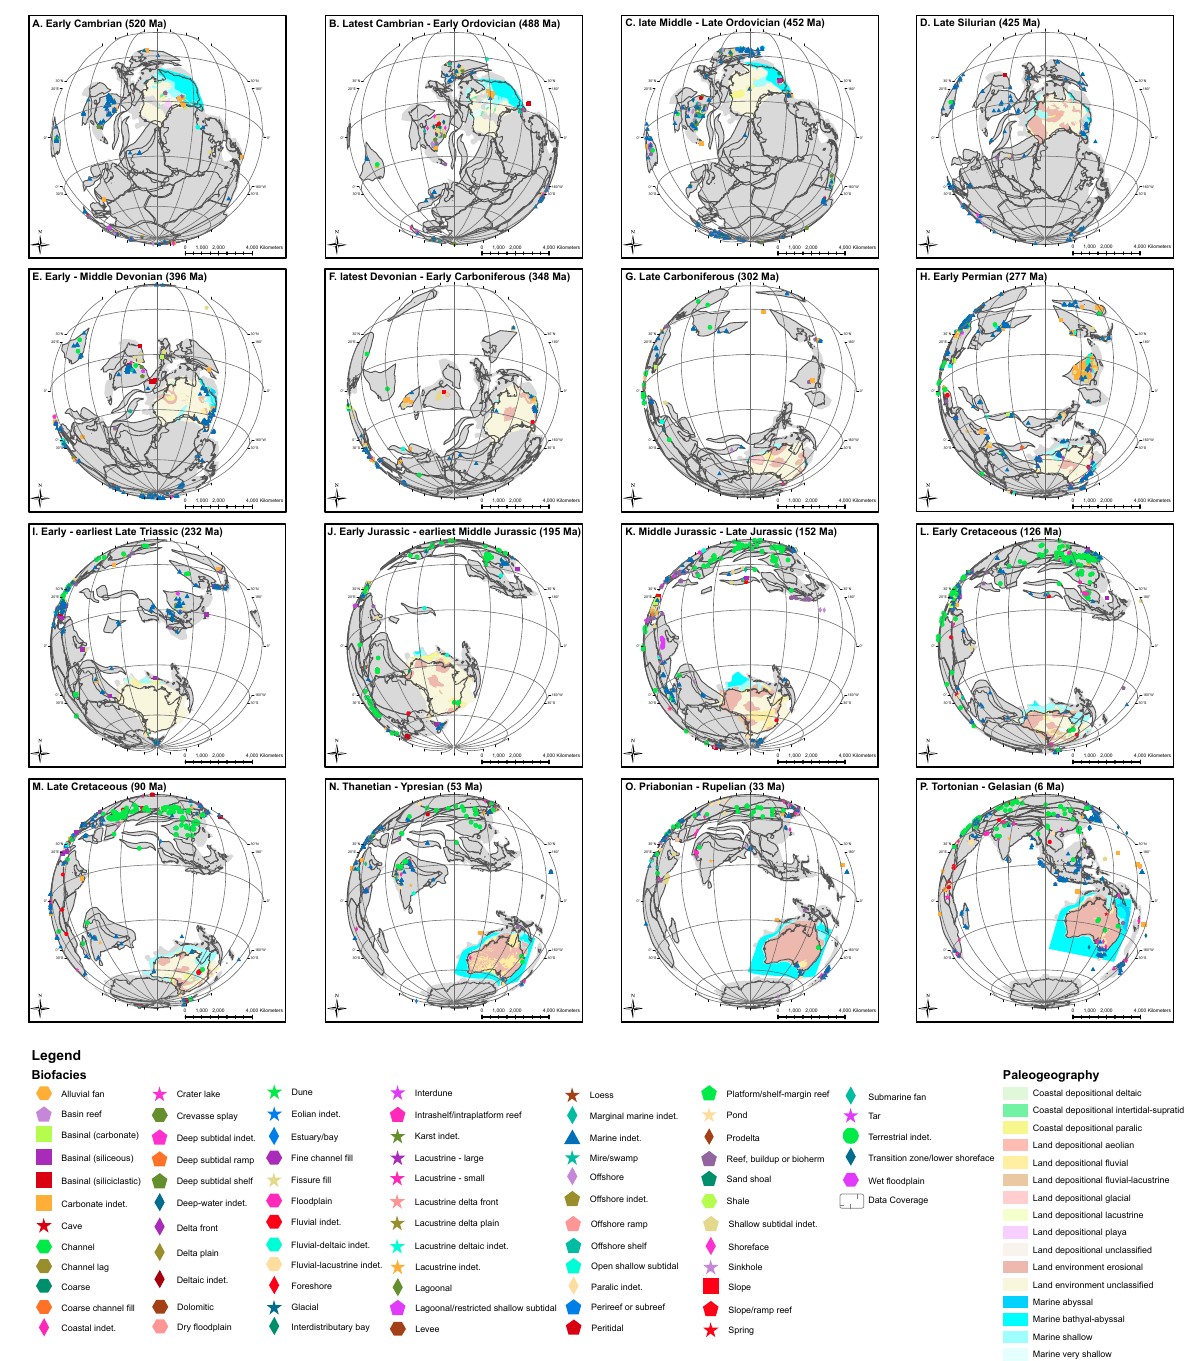
Fig. 4. Phanerozoic global plate reconstructions with Australian paleogeography and fossil indicators documenting the equatorial position of Australia in the Cambrian, followed by a south polar position by the end of the Paleozoic. The breakup of Pangea resulted in the northward motion of Australia back towards the equator. Increments are based on time slices presented by Golonka et al. (2006). Ages in the figure refer to the reconstruction time of each